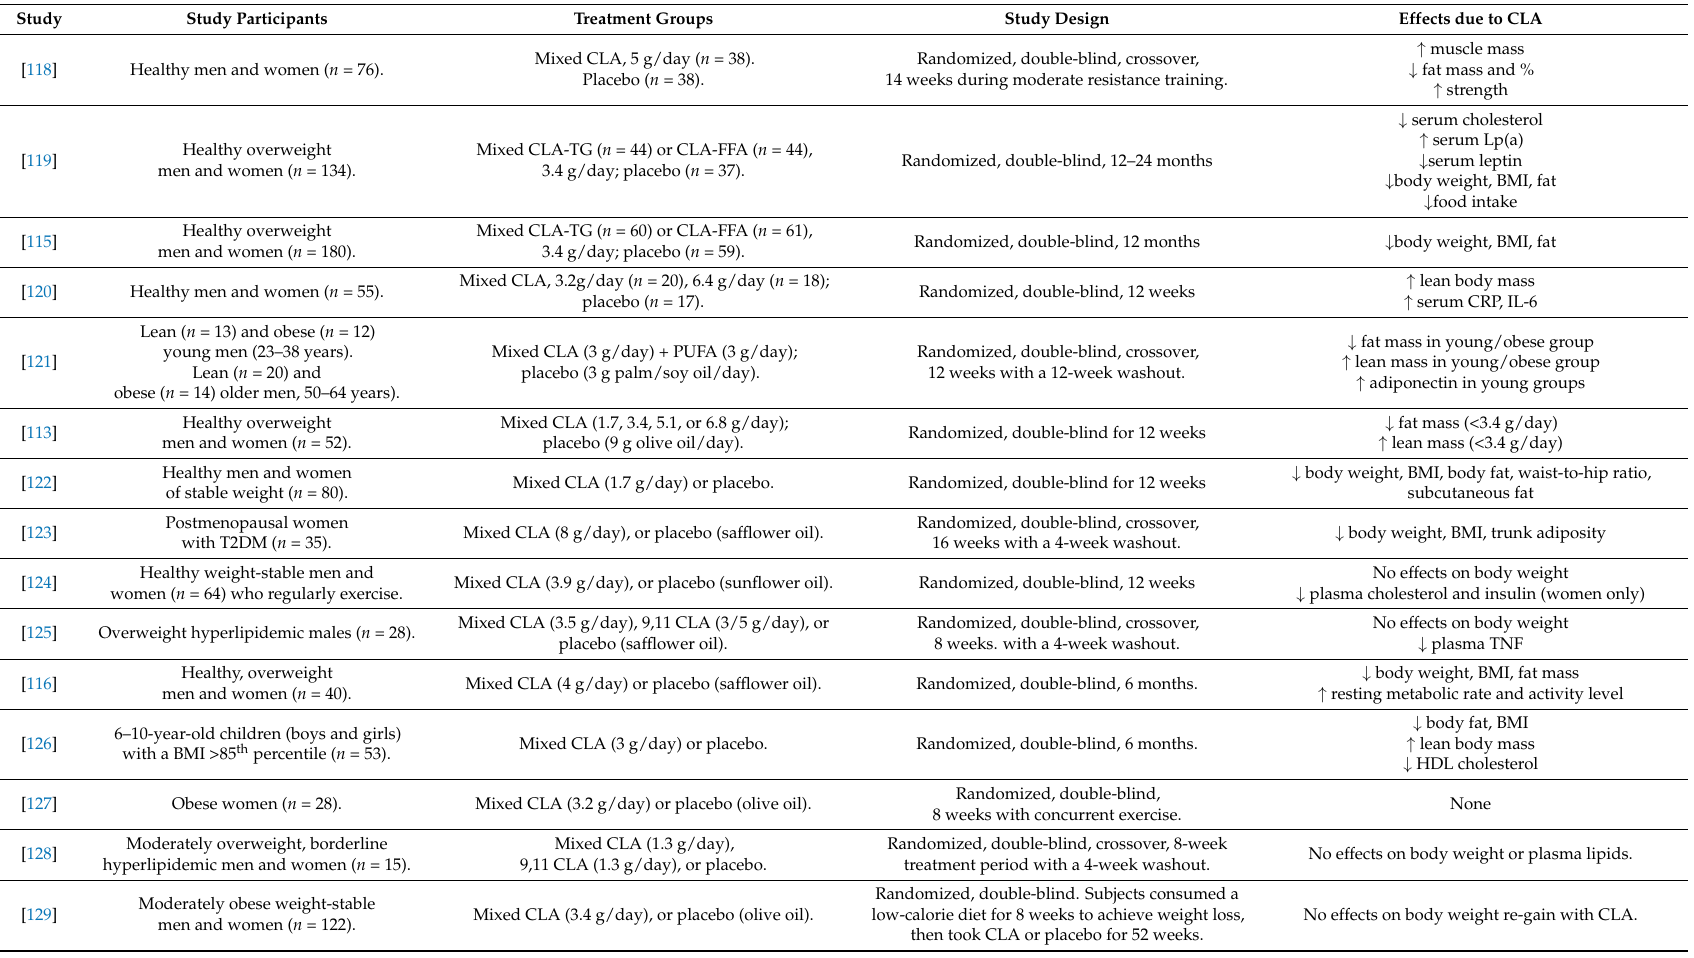
Table 1. Conjugated linoleic acid (CLA) studies in humans with the endpoint of body weight/composition.